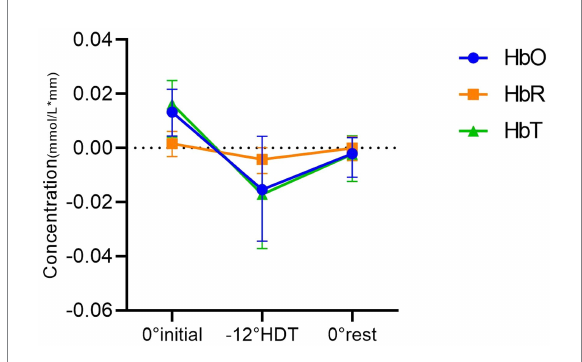
FIGURE 3 Comparison between groups of mean concentrations of HbO, HbR and HbT in different